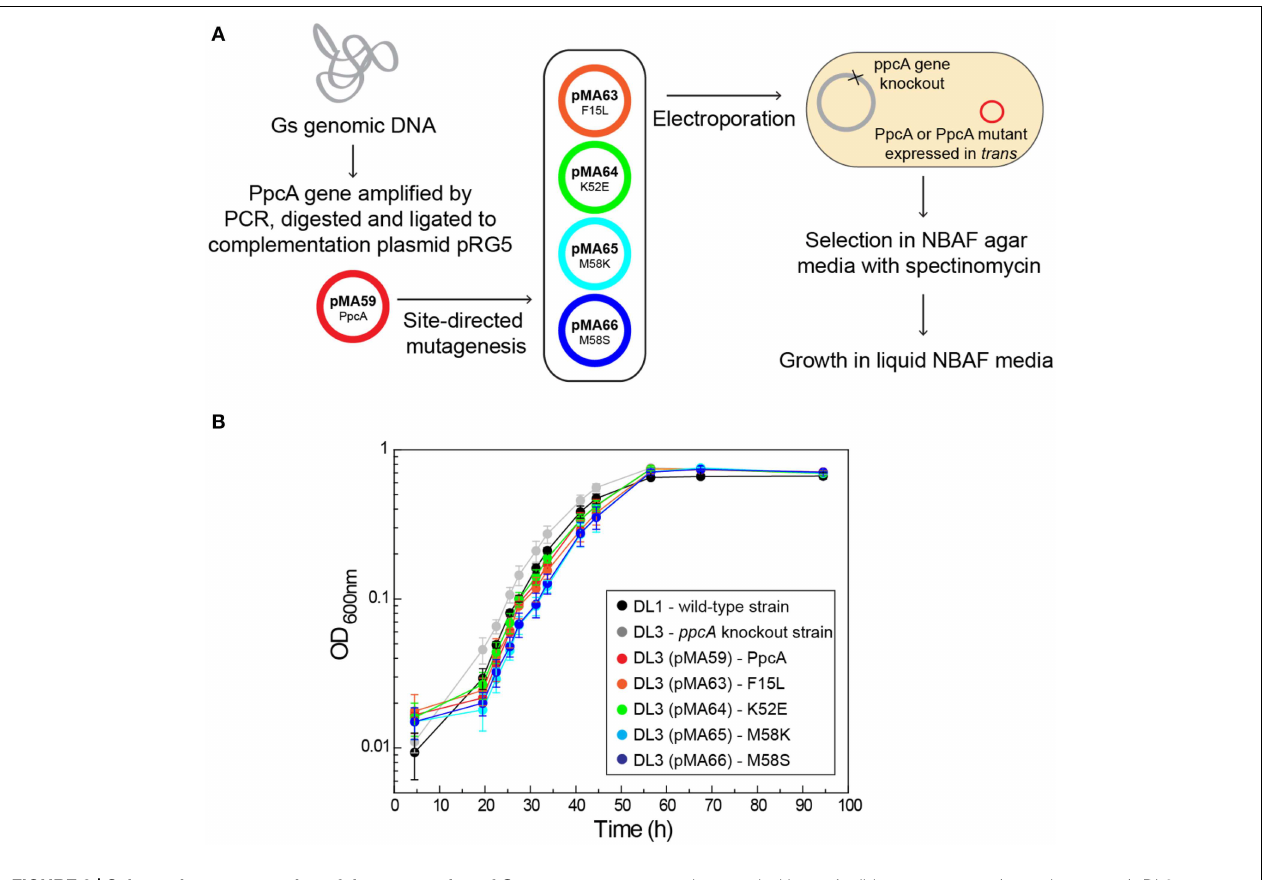
FIGURE 9 | Schematic representation of the preparation of G. sulfurreducens strains with mutated sequences of PpcA (A) and growth curves of G. sulfurreducens strains using acetate as electron donor and fumarate as electron acceptor (B). DL1, wild-type strain (black); DL3, ppcA knockout strain (gray); DL3 (pMA59), DL3 strain